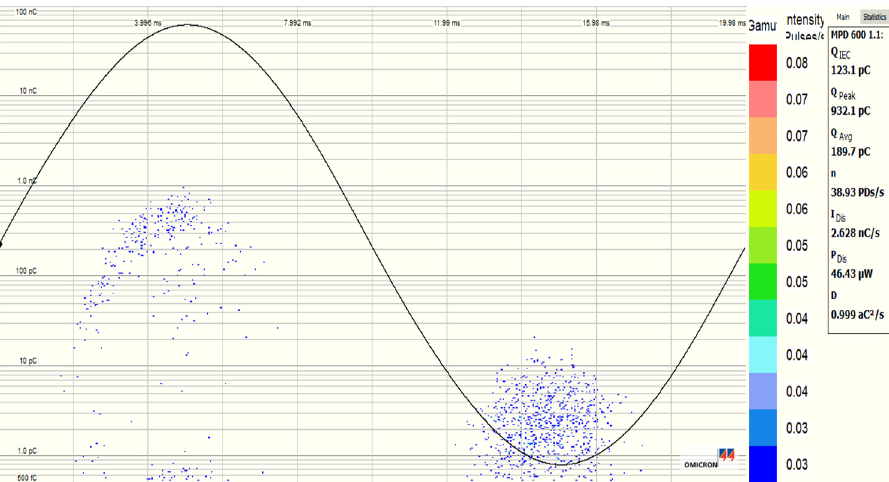
Figure 20. PD pattern of pure synthetic ester (MIDEL 7131) at 13 kV (RMS) voltage level.